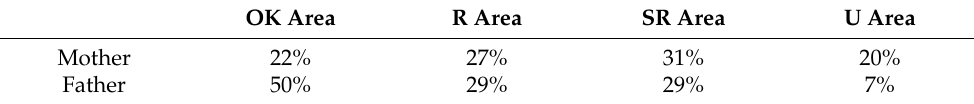
Table 2. Differences (%) in perceived strain load—FSQ. OK Area R Area SR